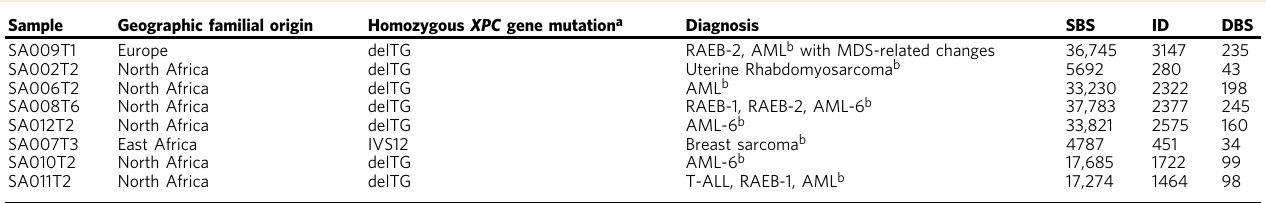
Table 1 Description of the studied XP-C